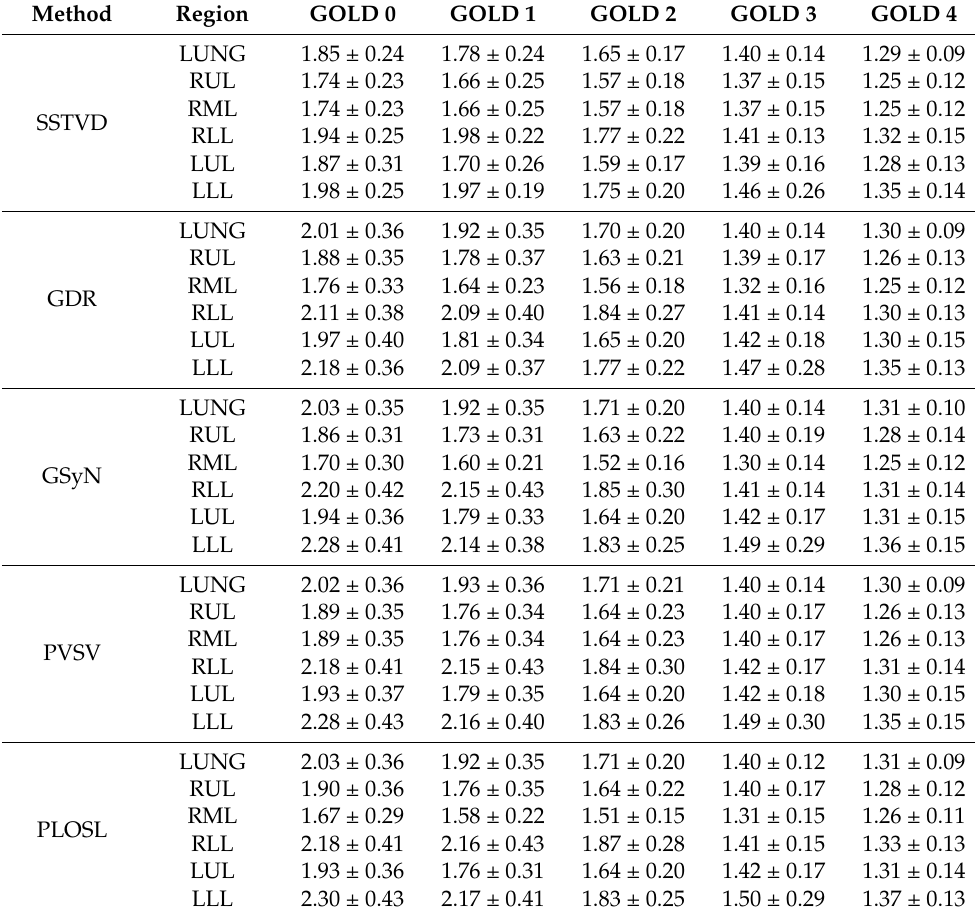
Table A2. Quantitative Results for Figure 6. Comparison of average J across image registration algorithms as a function of GOLD stages on both a global and lobe-by-lobe basis. Results are provided in mean ± standard deviation